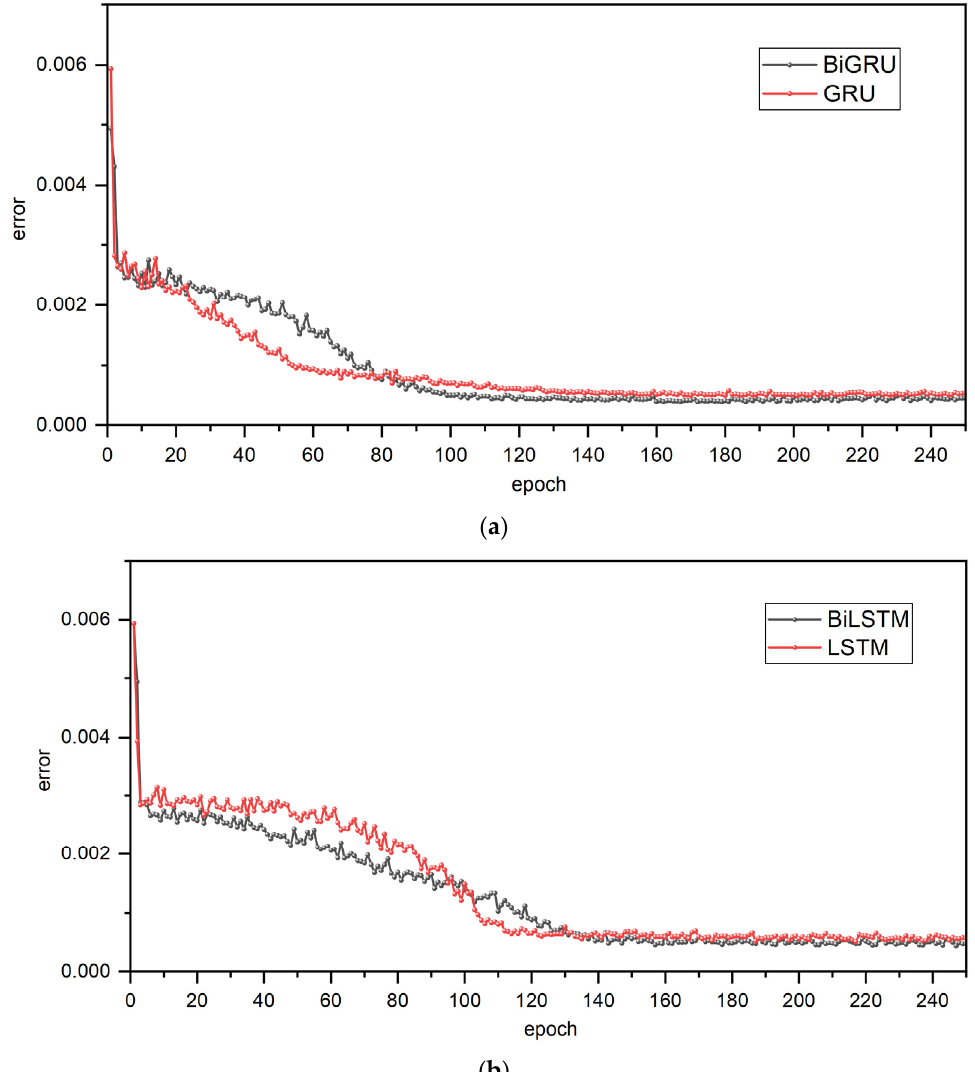
Figure 8. Loss value of comparative experiment based on the BiRNN structure. ( a ) BiGRU vs. GRU; ( b ) BiLSTM vs.